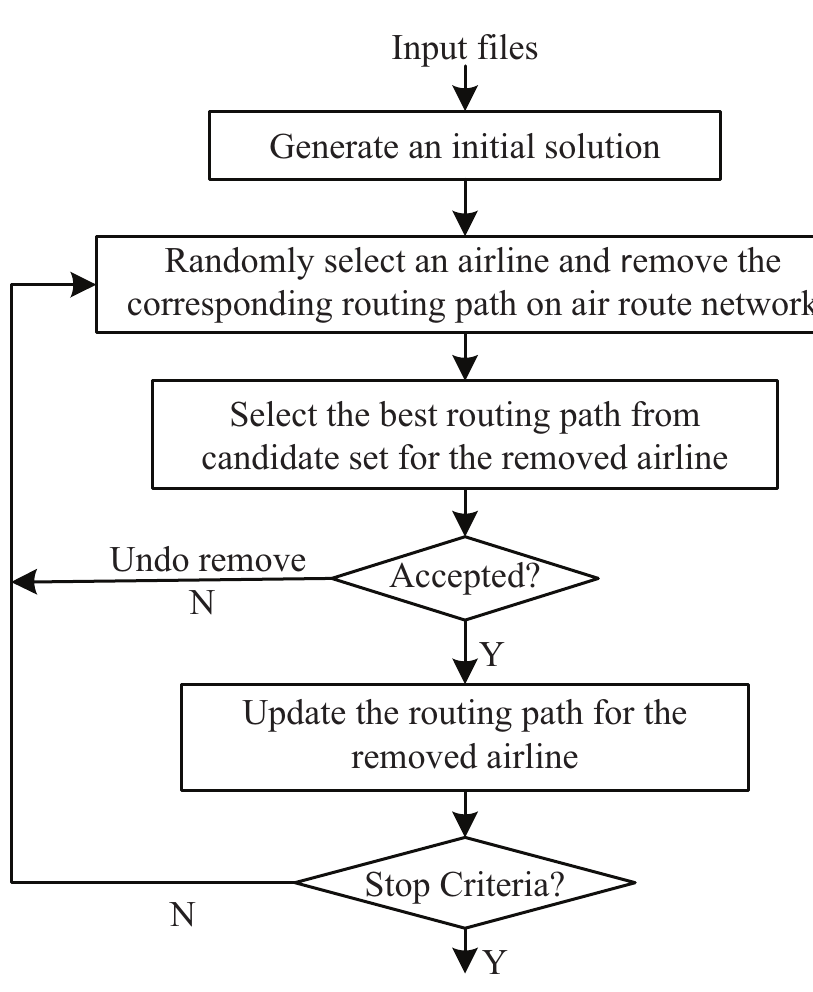
Figure 5. Optimization flow of routing paths for